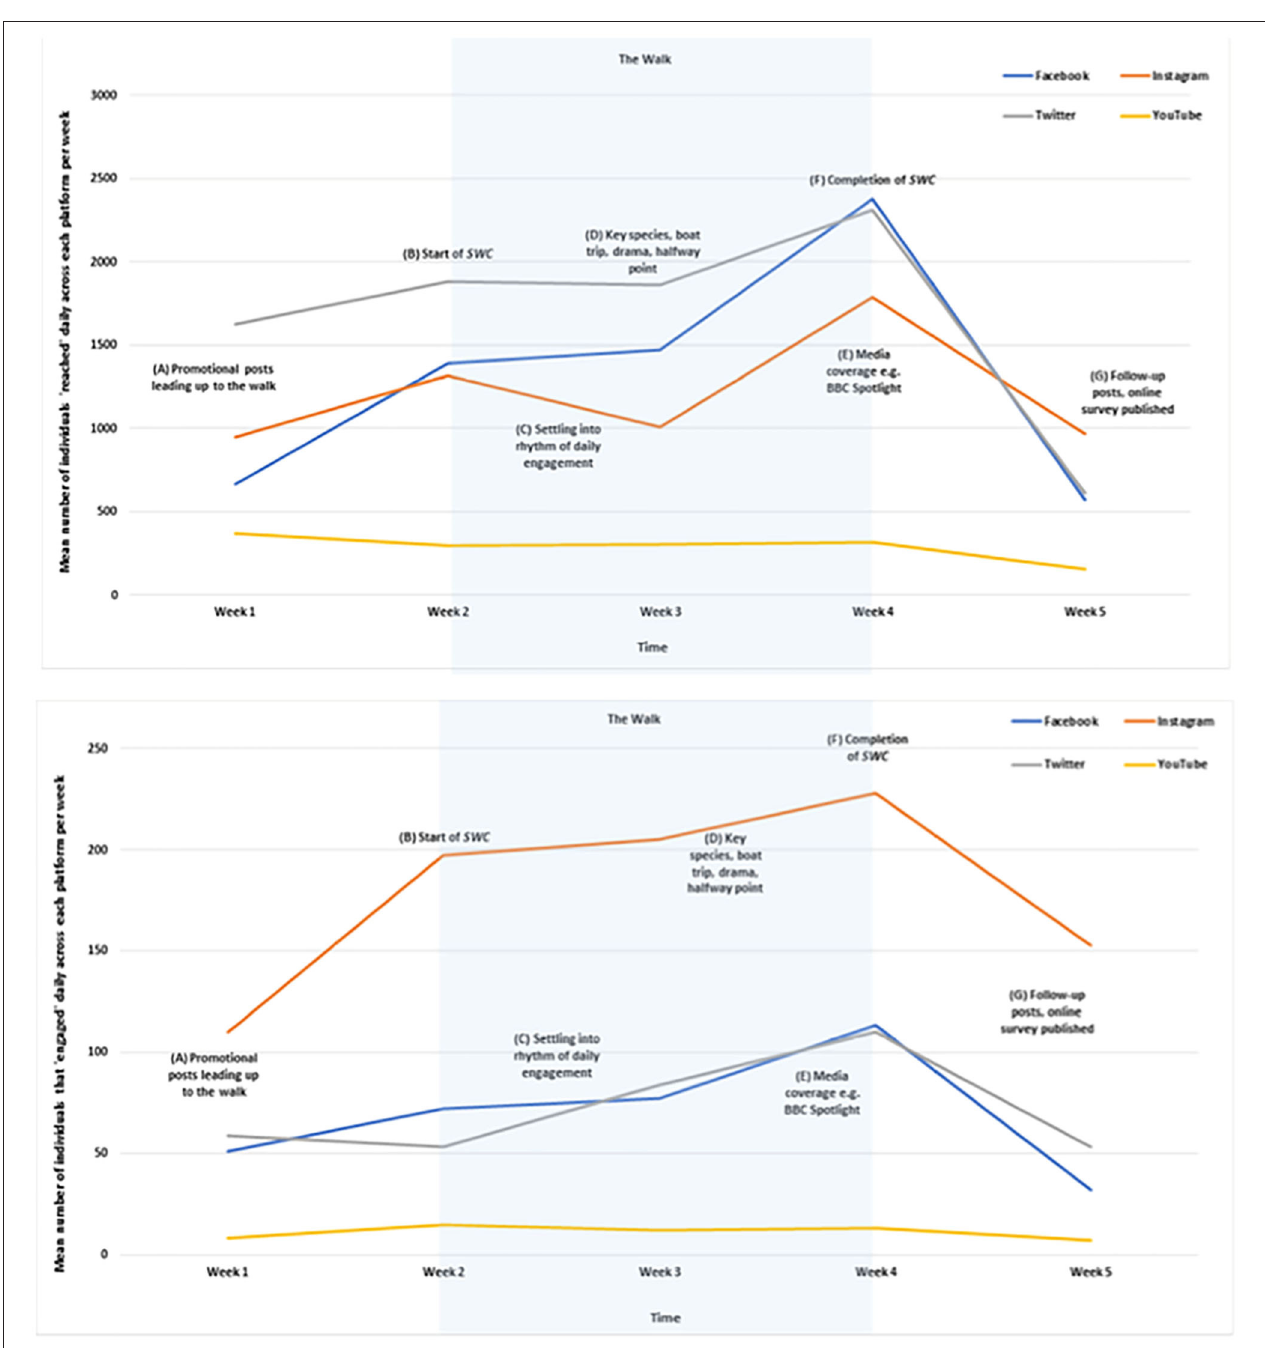
FIGURE 1 | The mean number of individuals “reached” and “engaged” across each social media platform used during Sophie’s Wild Cornwall throughout the 5-week measurement period. Labels indicate key chronological events during the walk that likely influenced noticeable changes in audience reach and overall engagement